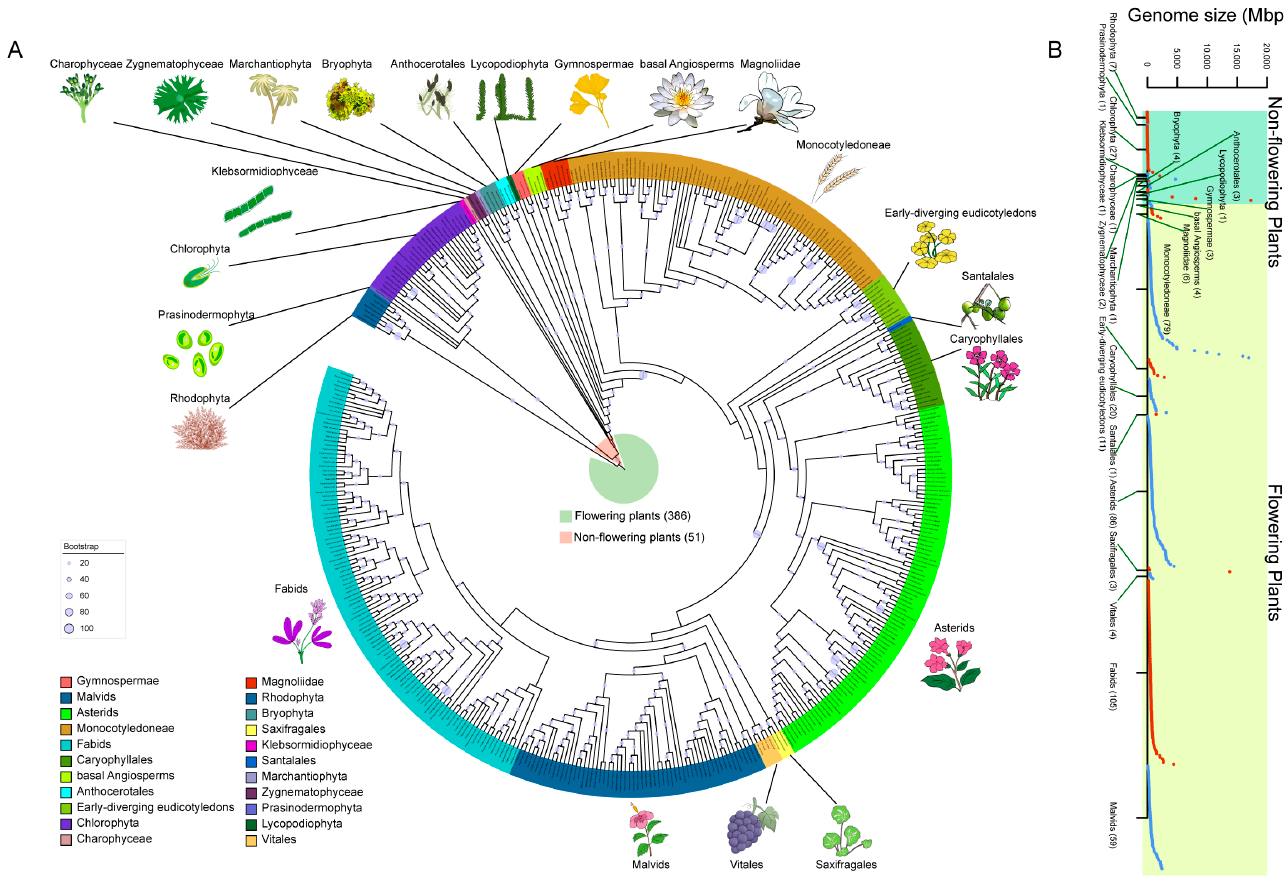
Figure 1. The phylogeny and genome size distribution of the 437 plant species. ( A ) Phylogenetic tree of the 437 plant species. Species were marked in different color in the outer circle to show the 22 categories (legend shown on bottom left). Representative species in each of the 22 categories was indicated and their morphology was shown. Light blue pies on the tree indicate bootstrap support of each branch with the pie size increases when bootstrap value goes high. The tree was reconstructed using the R package ‘rotl’, based on the Open Tree of Life data API. ( B ) The genome size of 437 plant species. Each point represents a species. The y -axis represents the genome size. Species with each of the 22 categories were ordered based on their genome size. The green background included 51 non-flowering plants and the yellow included 386 flowering plants.